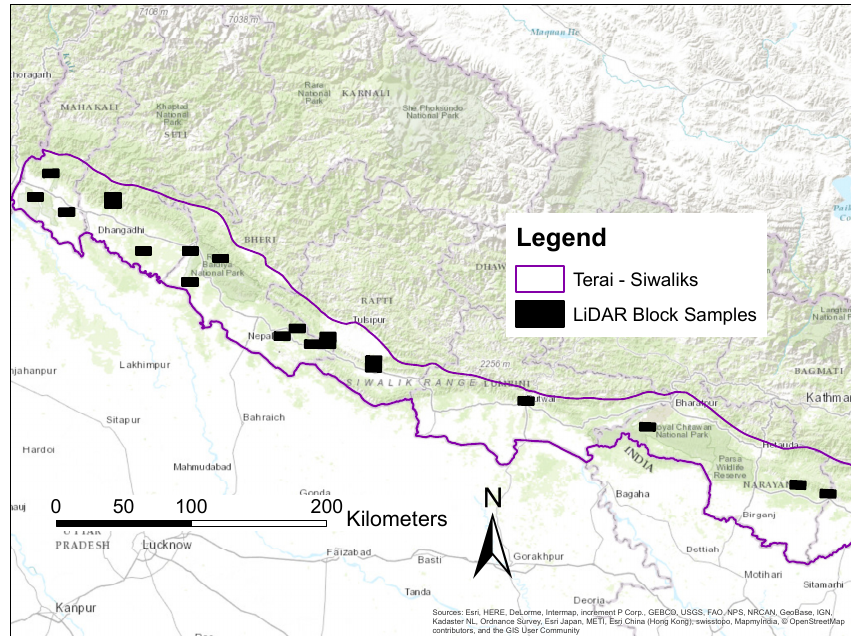
Figure 1. LiDAR blocks in TAL.